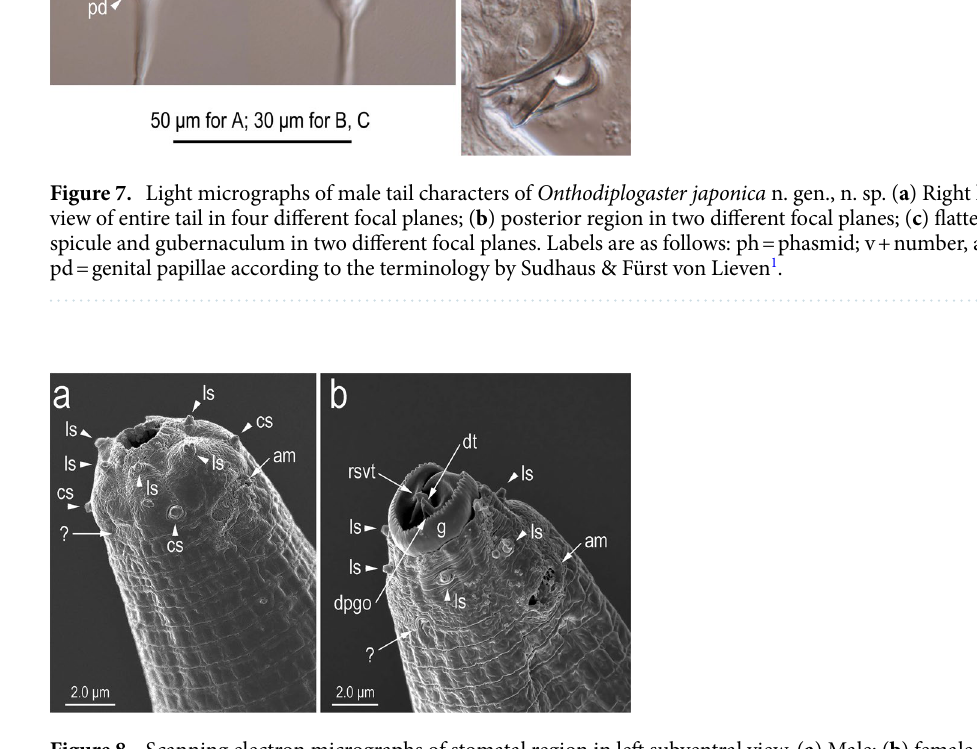
Figure 8. Scanning electron micrographs of stomatal region in left subventral view. ( a ) Male; ( b ) female with everted gymnostom and stegostom. Labels are as follows: am = amphid; cs = cephalic sensilla; dpgo = dorsal pharyngeal gland orifice; dt = dorsal tooth; g = gymnostom; ls = labial sensilla; rsvt = right subventral tooth; ? = an indentation with unknown